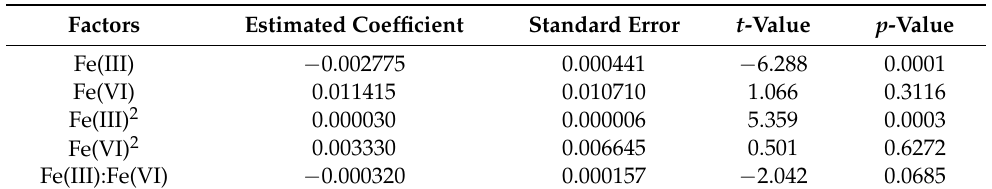
Table 3. t- test coefficients for a Quadratic Polynomial Regression Model with interaction that explains the final arsenic concentration at the initial As(V) concentration of 1000 µg L − 1 .